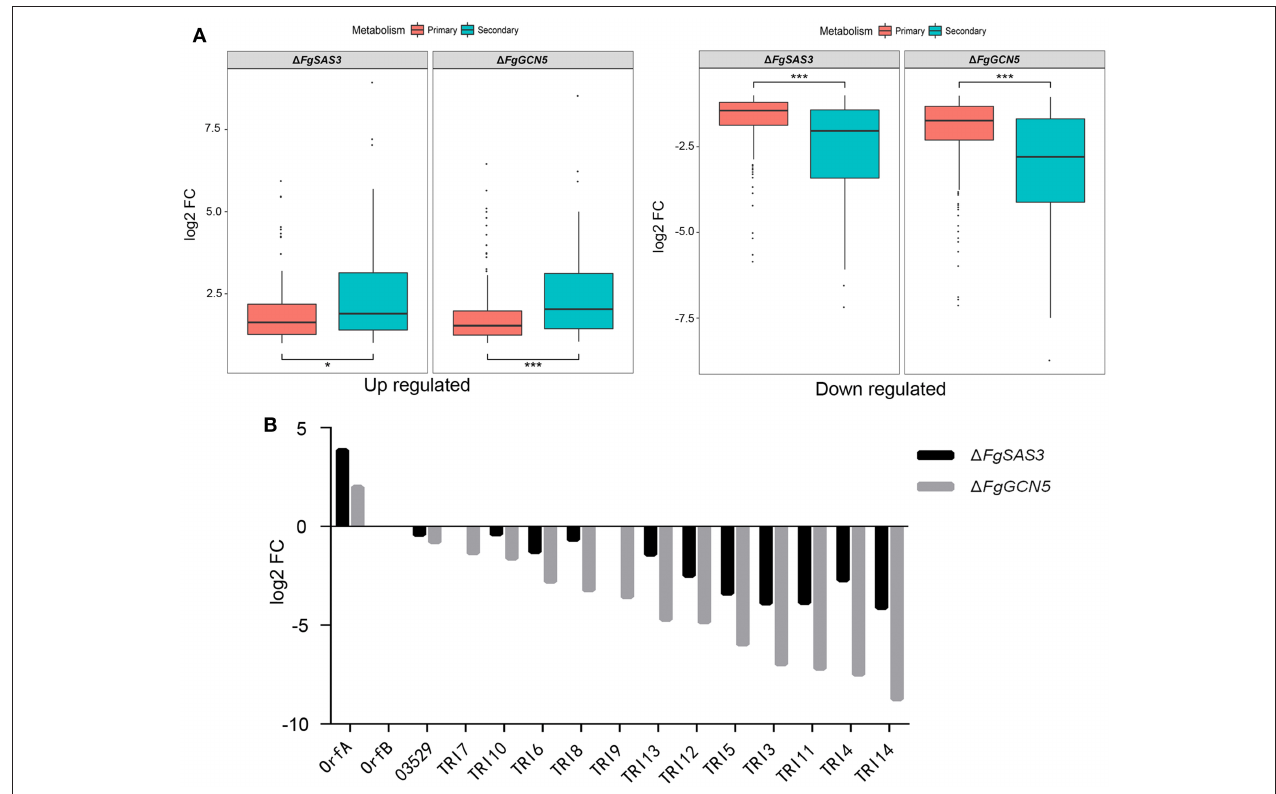
FIGURE 6 | DEGs in primary and secondary metabolism and expression of all trichothecene biosynthesis related genes. (A) Boxplots for distribution of DEGs in primary and secondary metabolism. Primary metabolic genes were affected to a lesser extent compared to secondary metabolic genes in both mutants. Mild outliers were indicated by dot and asterisks highlight extreme outliers. * P < 0.05, *** P < 0.001. (B) Expression of all trichothecene biosynthesis related genes from transcriptome analyses. Almost all of the genes were down regulated in 1 FgSAS3 and 1 FgGCN5